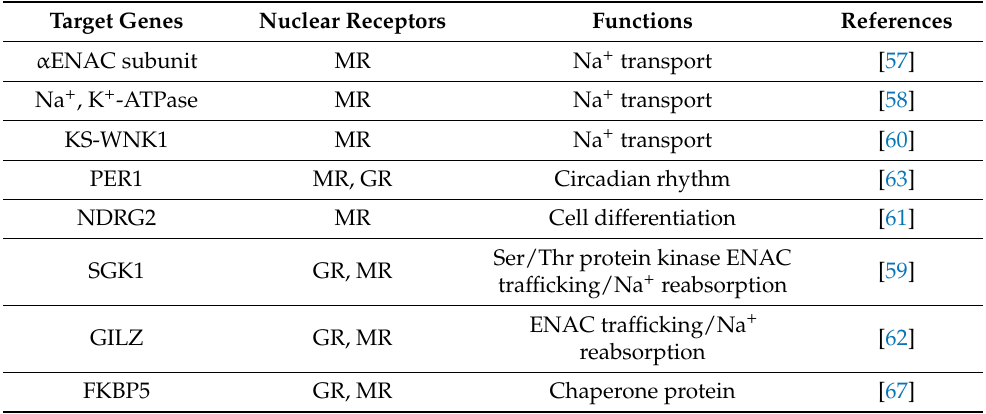
Table 1. MR and GR target genes in renal principal